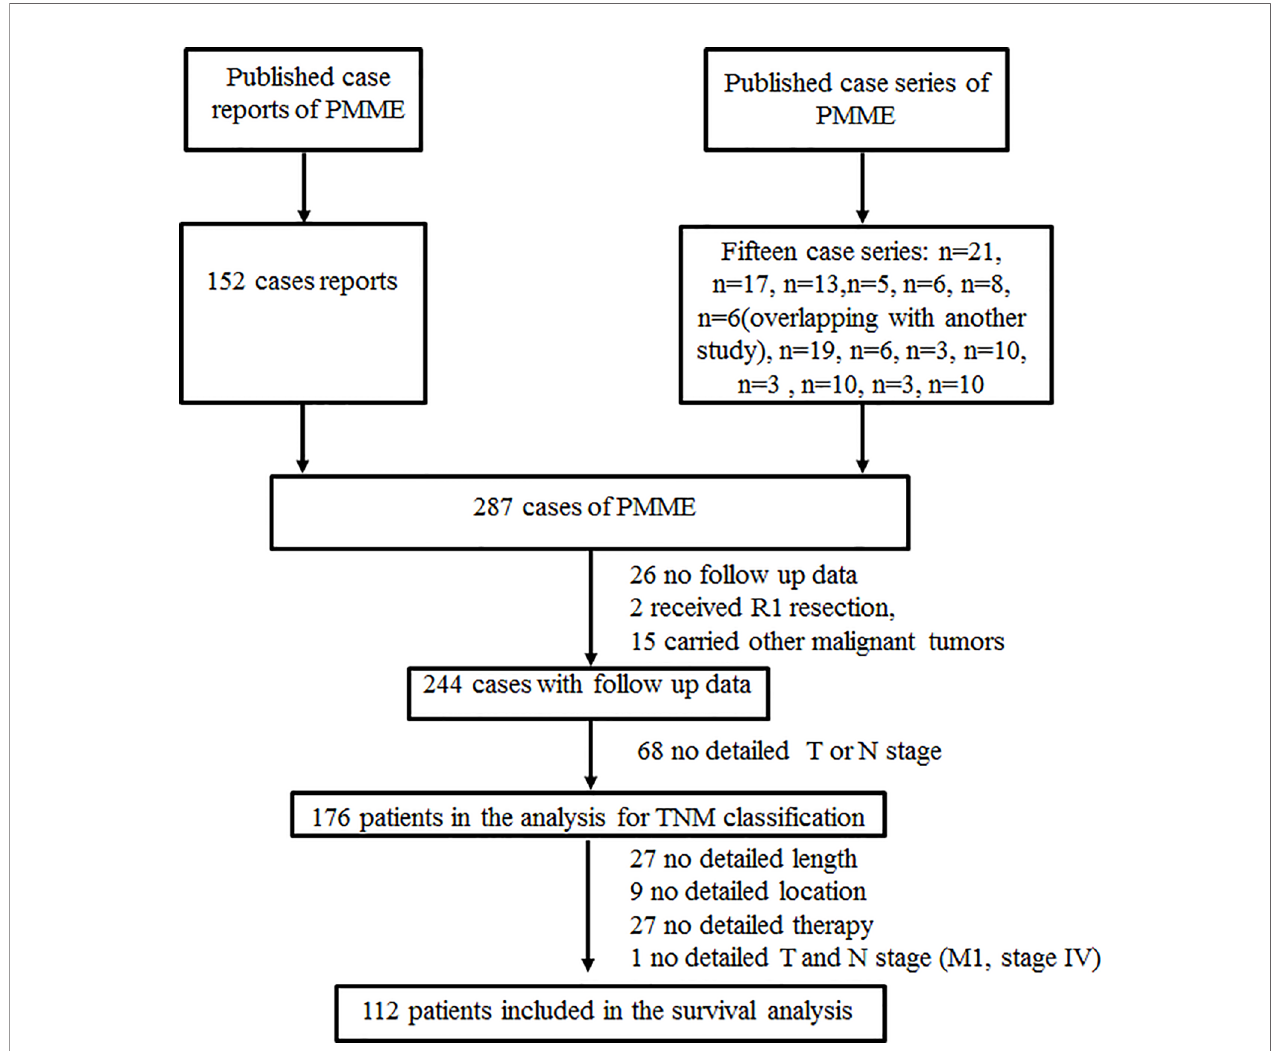
FIGURE 1 | Schematic of the selection of the esophageal melanoma